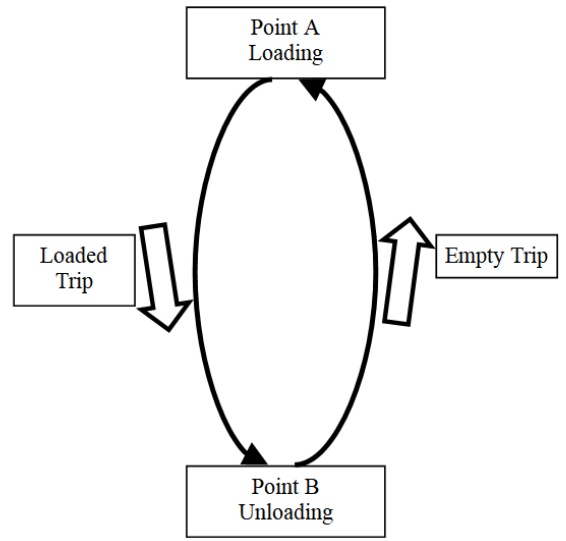
Figure 4. Railway considered in the case study.